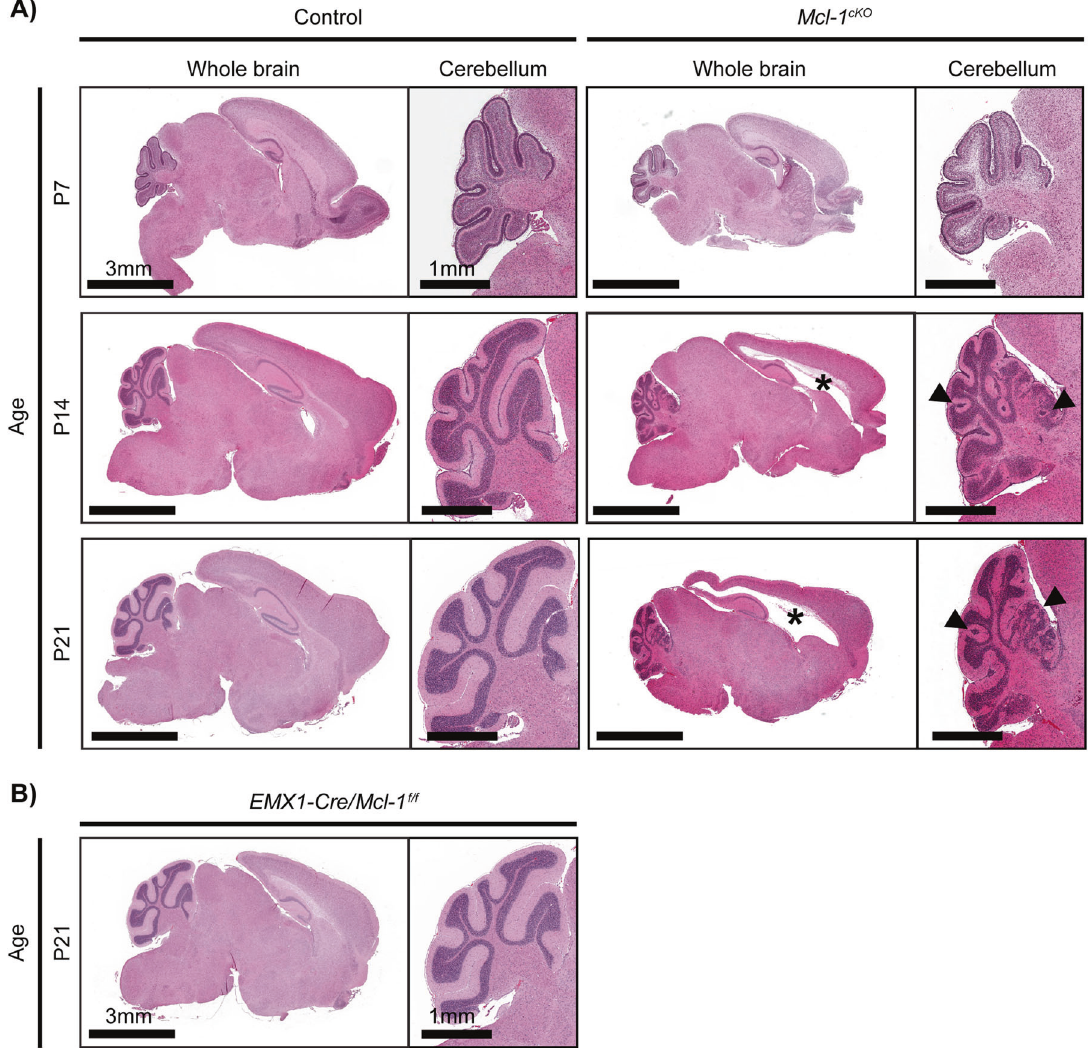
Fig. 1 Mcl-1 deletion causes progressive white matter degeneration. Brains of representative ( A ) Mcl-1 cKO or ( B ) Emx-Cre/Mcl-1 f/f mice shown in H&E-stained sagittal sections appear similar to controls at P7. By P14, Mcl-1 cKO mice develop white matter degeneration with ventricular enlargement (*) and abnormal migration of cerebellar granule neurons (arrows). White matter loss increases by